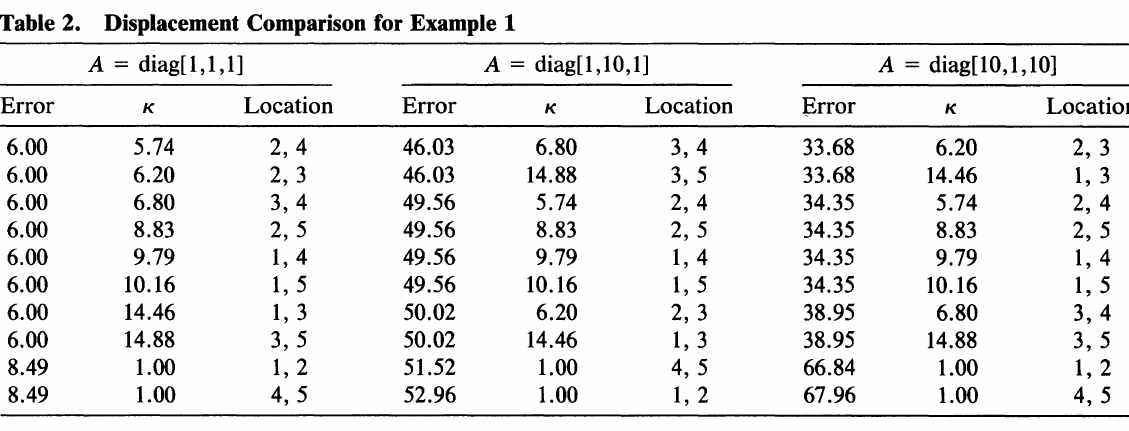
Table 2. Displacement Comparison for Example